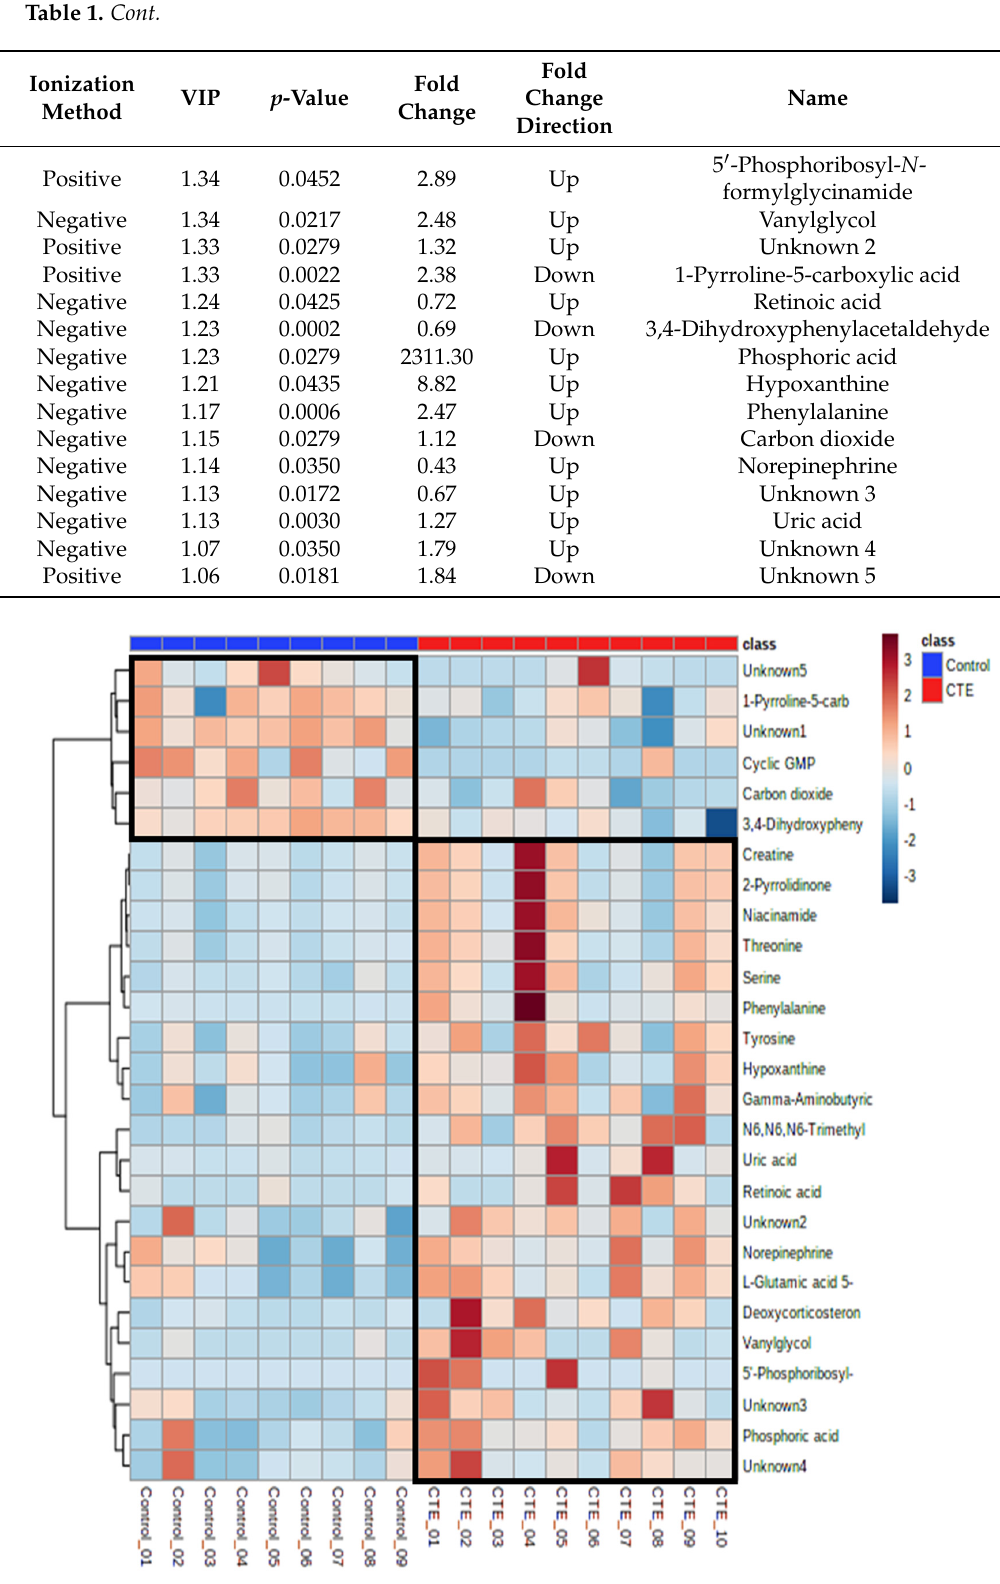
Figure 2. Heatmap of the 27 significantly altered metabolites in the CTE and healthy control groups. The colors blue to red indicate the concentration of metabolites from the lowest to the